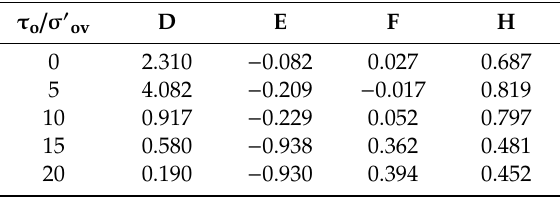
Table 11. Values of the constants D, E, F, and H of the empirical relation (7) for different normalized monotonic stress τ o / σ′ ov in the particular case of this investigation.